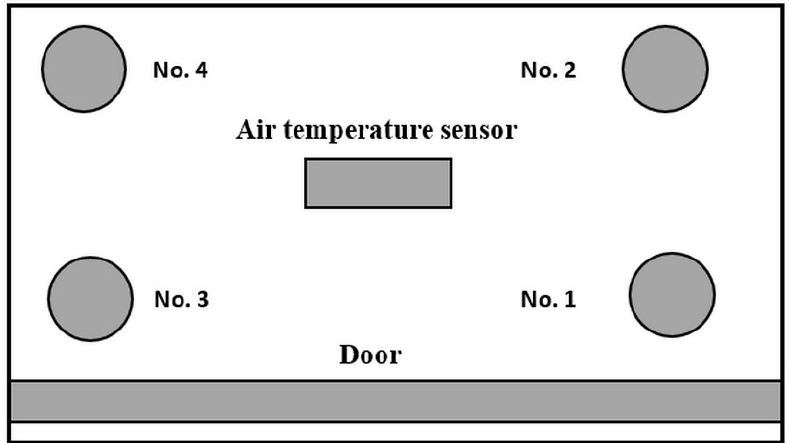
Figure 3. Position of 100 mL PBM bottles (No. 1–4) in the refrigerator during the measurement of the slow thawing temperature history, viewed from above.